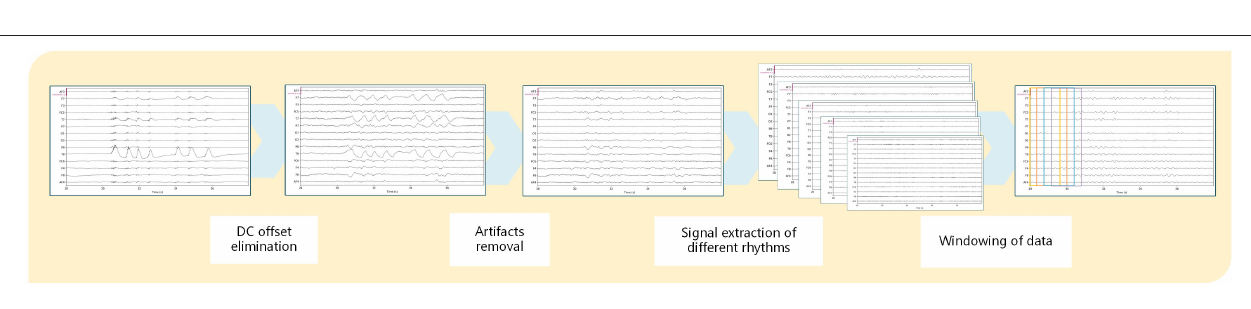
FIGURE 2 | Flowchart of the data